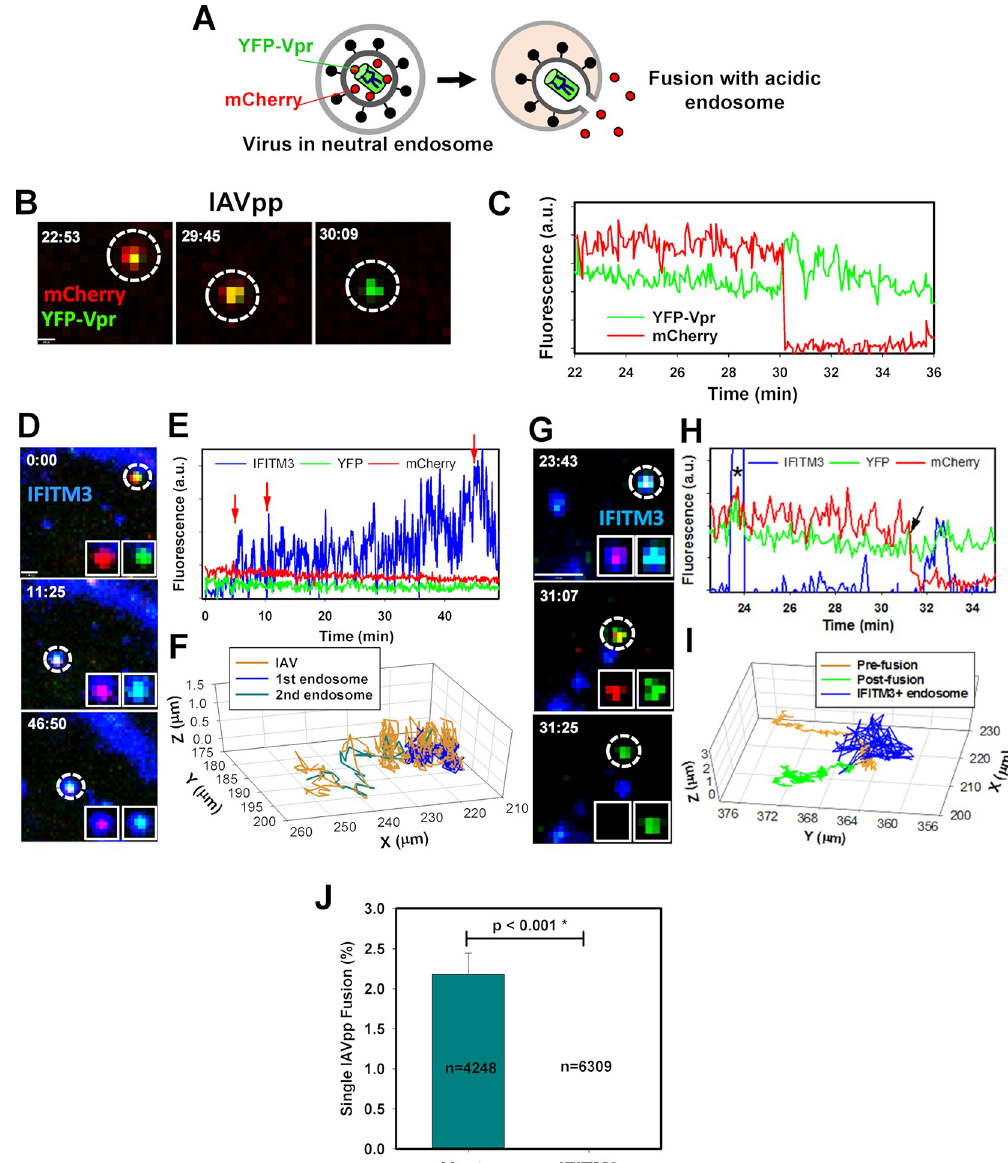
Fig 3. IFITM3 co-traffics with IAV and restricts viral fusion. (A) Schematic illustration of the single-virus fusion assay. Pseudoviruses bearing influenza virus HA and NA glycoproteins (IAVpp) are co-labeled with mCherry-2xCL-YFP-Vpr. Membrane fusion resulting in pore formation leads to the release of mCherry into the cytoplasm that appears as sudden loss of the red signal. In this model, the YFP marker remains associated with the core. (B) Timelapse images from the single IAV fusion event show the loss of mCherry signal at around 30 min, indicating a fusion event. Scale bar 2.8 μ m. (C) Fluorescence trace of the fusion event shown in panel B. (See S4 Movie). (D) Time-lapse imaging was performed using IAVpp co-labeled with mCherry-2xCL-YFP-Vpr in A549-IFITM3-imTFP1 cells. Single frames show IAVpp co-trafficking within an IFITM3 + compartment without undergoing fusion. Scale bar 0.8 μ m. (E) Fluorescence intensity analysis of the virion shown in panel D. The red arrow around 7 minutes indicates virus entry into an IFITM3+ endosome and the second and third arrows mark subsequent merger of the virus-carrying endosome with additional IFITM3+ vesicles around 10 min and 43 min, leading to increases in the IFITM3 intensity. (F) Particle tracking in 3D confirms co-trafficking of the IAVpp (dark yellow) with an IFITM3+ endosome (green) followed by merging with a second IFITM3+ endosome (blue). (See S5 Movie). (G) IAVpp were labeled as in A. Time series images show fusion of IAVpp within an IFITM3 expressing cell at a location that does not contain above-threshold amounts of IFITM3-imTFP1. IAVpp comes into proximity with an IFITM3-containing compartment but does not co-traffic with it. Fusion occurs prior to transient colocalization with an IFITM3-imTFP1 spot. (See also S3 Fig). (H) Fluorescence traces of the particle shown in (G). Transient colocalization with an IFITM3+ endosome and subsequent